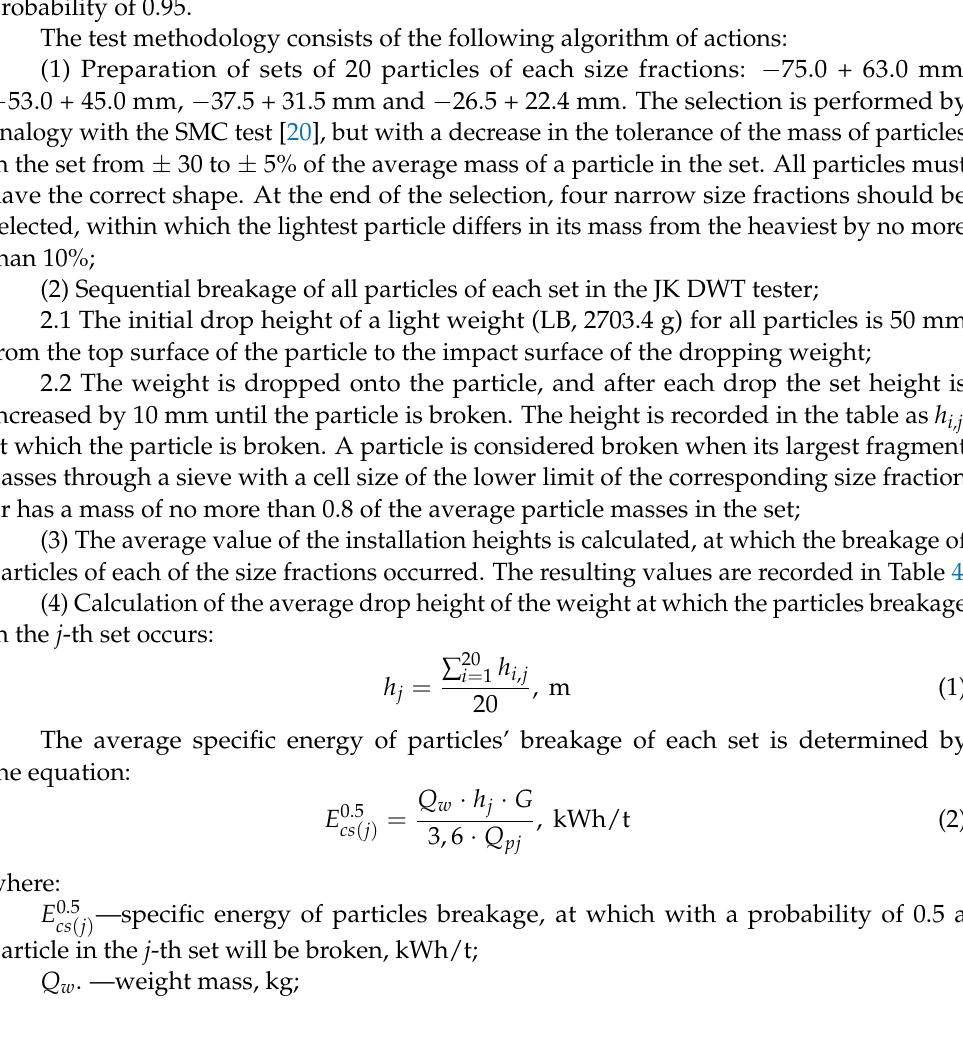
Figure 14. The dependence of the probability of breakage of particles on specific impact energy. To analyze the curves of energy spectra, it is necessary to determine the nominal specific impact energy E 0.95 , at which a particle of a certain size will be broken with a cs ( j ) probability of